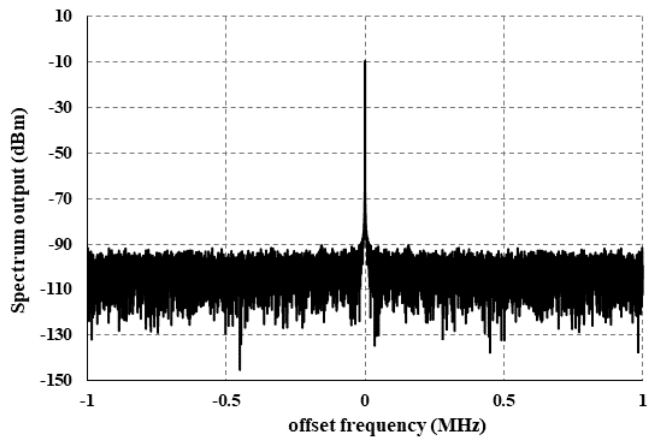
Figure 9. The simulated phase noise of the VCO at 48.11 GHz.